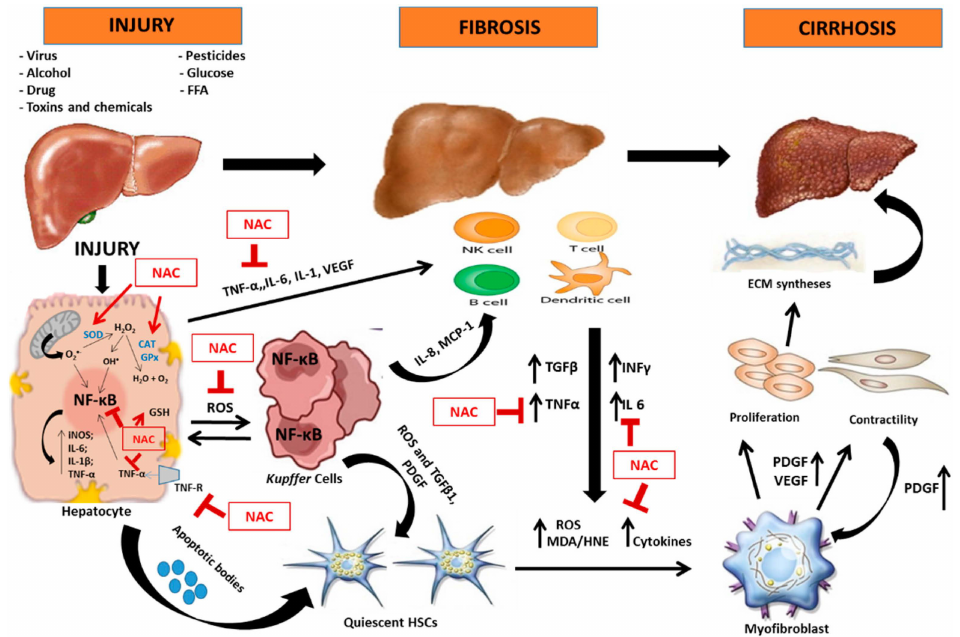
Figure 4. Possible molecular mechanisms of action of N -acetylcysteine (NAC) in attenuation of liver injury involving oxidative stress and inflammation. Adapted from Cohen-Naftaly; Scott L. Friedman, 2011. Legend: CAT: catalase; ECM: extracellular matrix; FFA: free fatty acids; GPx: glutathione peroxidase; HSCs: hepatic stellate cells; iNOS: inducible nitric oxide synthase; IL: interleukin; INF γ : interferon gamma; MCP-1: monocyte chemoattractant